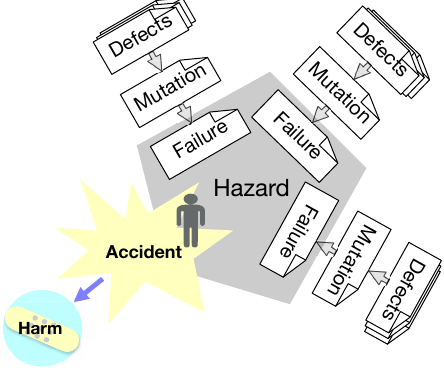
Figure 3. The accident causality